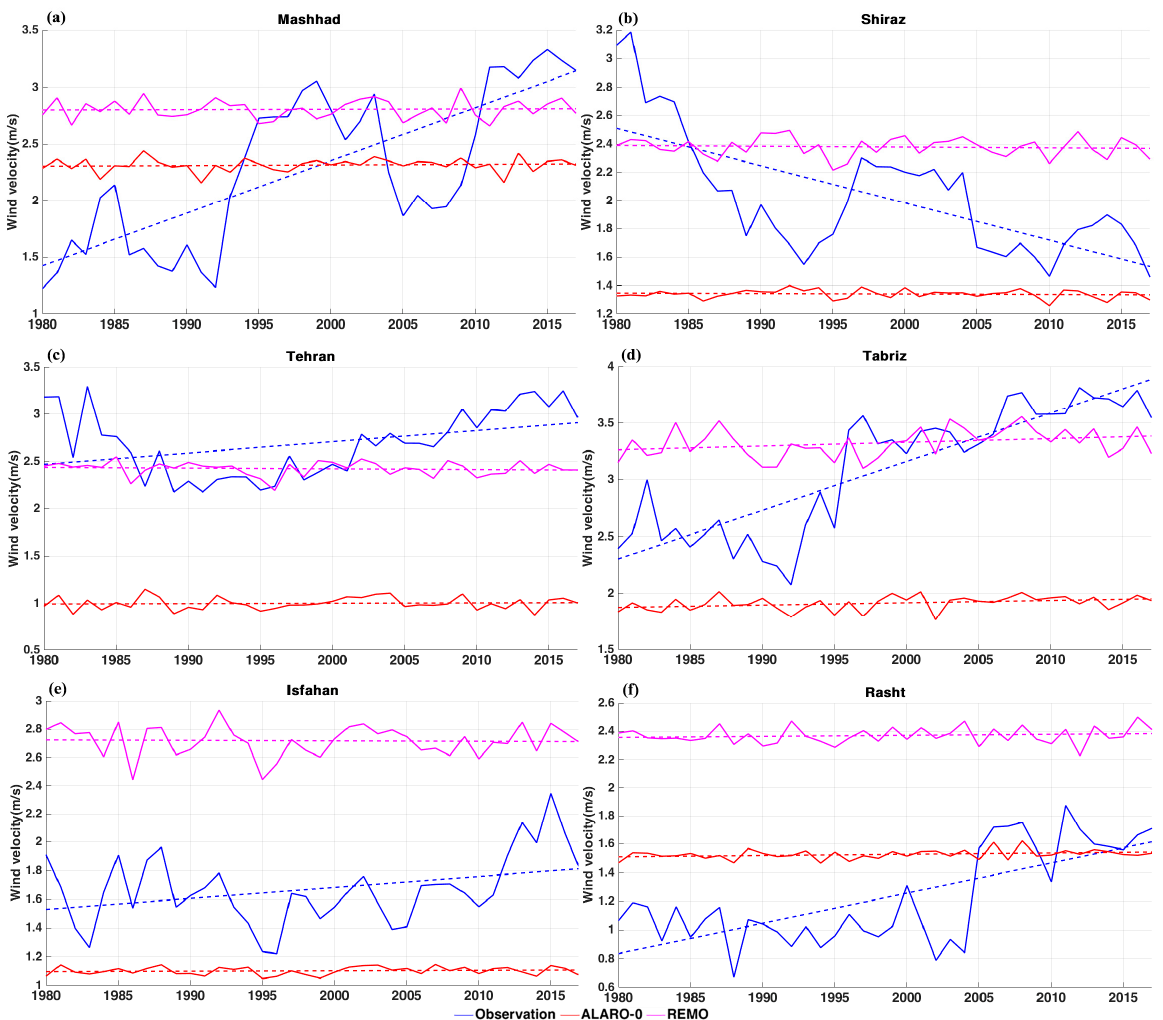
Figure 18. Total annual wind-driven rain for dominant wind direction comparing ALARO-0 and REMO with observations over six studied stations: Mashhad ( a ), Shiraz ( b ), Tehran ( c ), Tabriz ( d ), Isfahan ( e ) and Rasht ( f ) during